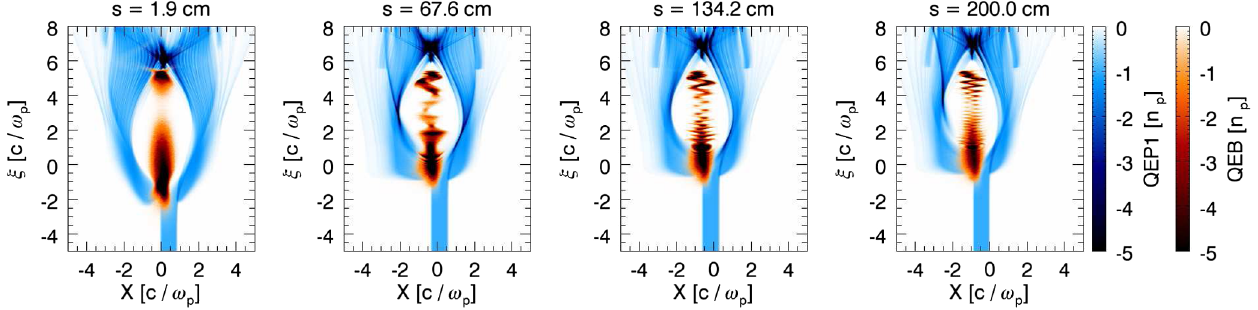
FIG. 10. Snapshots of beam and plasma densities from the simulation where the laser precursor drifts to the left in the rest frame of the